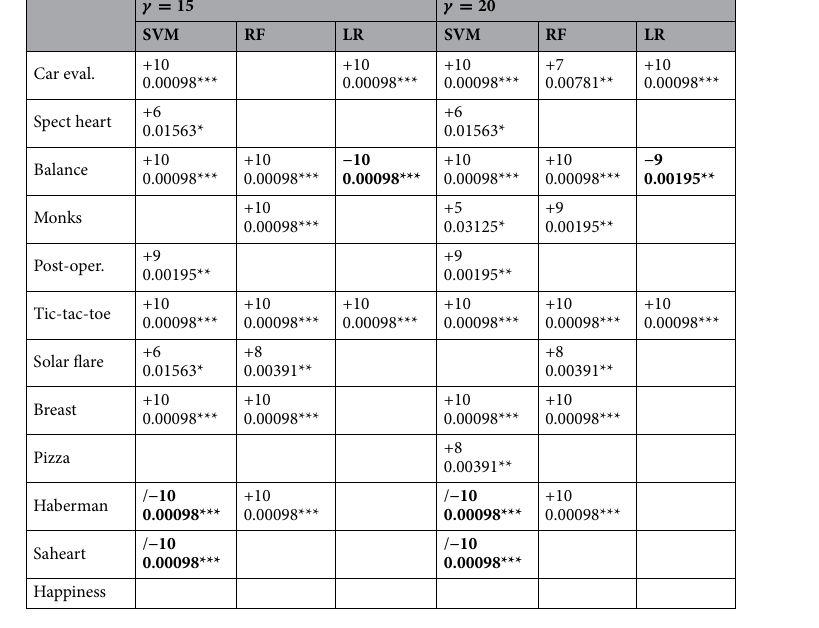
Table 9. Analogous to Table 8 but with γ = 15, 20 .